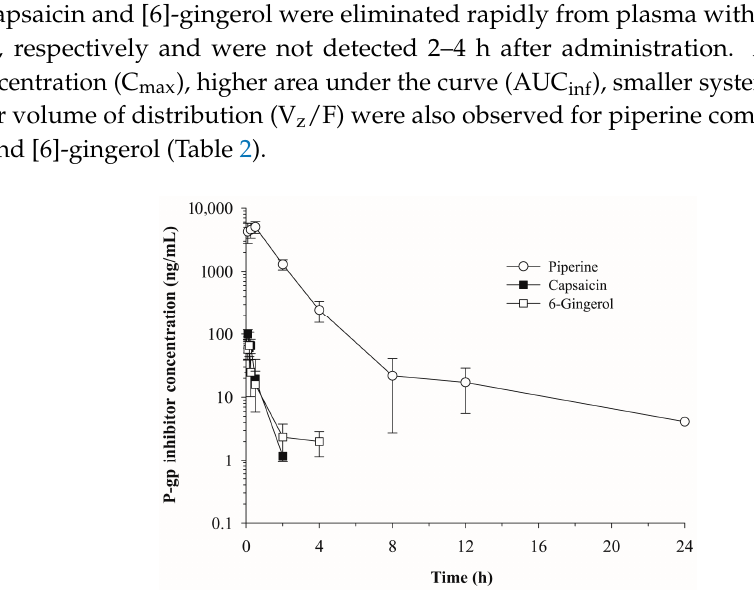
Figure 1. Plasma concentration vs. time profiles of piperine, capsaicin and [6]-gingerol after intraperitoneal injection in mice ( n = 6, mean ± SD). Table 2. Average pharmacokinetic parameters of phytochemical P-gp inhibitors after intraperitoneal injection in mice.